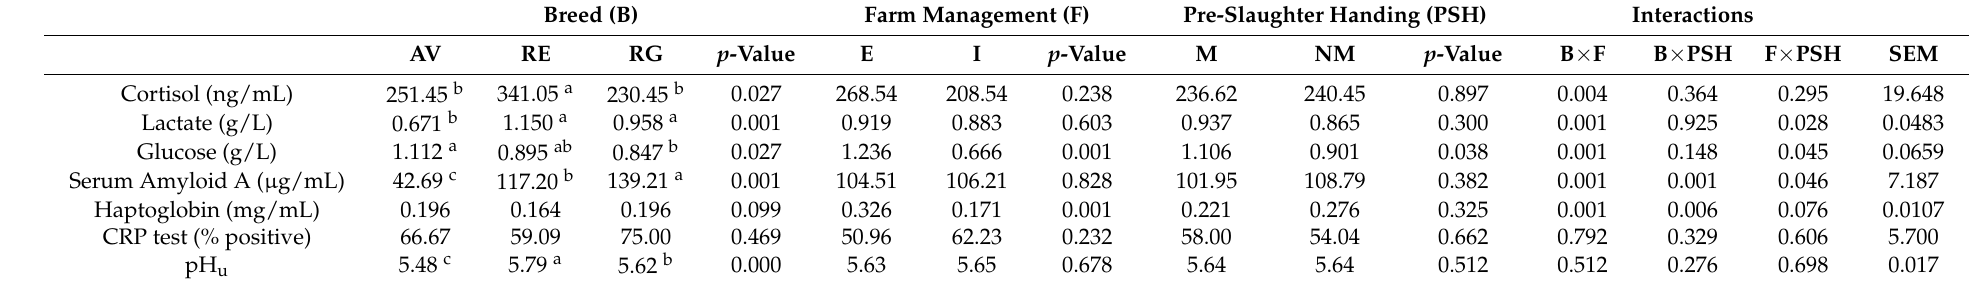
pH u 0.512 0.512 0.276 0.698 0.017 Values with the same letters (a, b, c) indicate homogeneous subsets for p = 0.05 according to Tukey’s test; SEM: Standard Error of Mean; B × F, B × PSH and F × PSH interactions resulted p ≥ 0.05 for all parameters. AV: Asturiana de los Valles breed ( n = 24); RE: Retinta breed ( n = 22); RG: Rubia Gallega breed ( n = 32); E: Extensive production system ( n = 39); I: Intensive production system ( n = 39); M: Mixing of animals ( n = 40); NM: No- mixing of animals ( n =